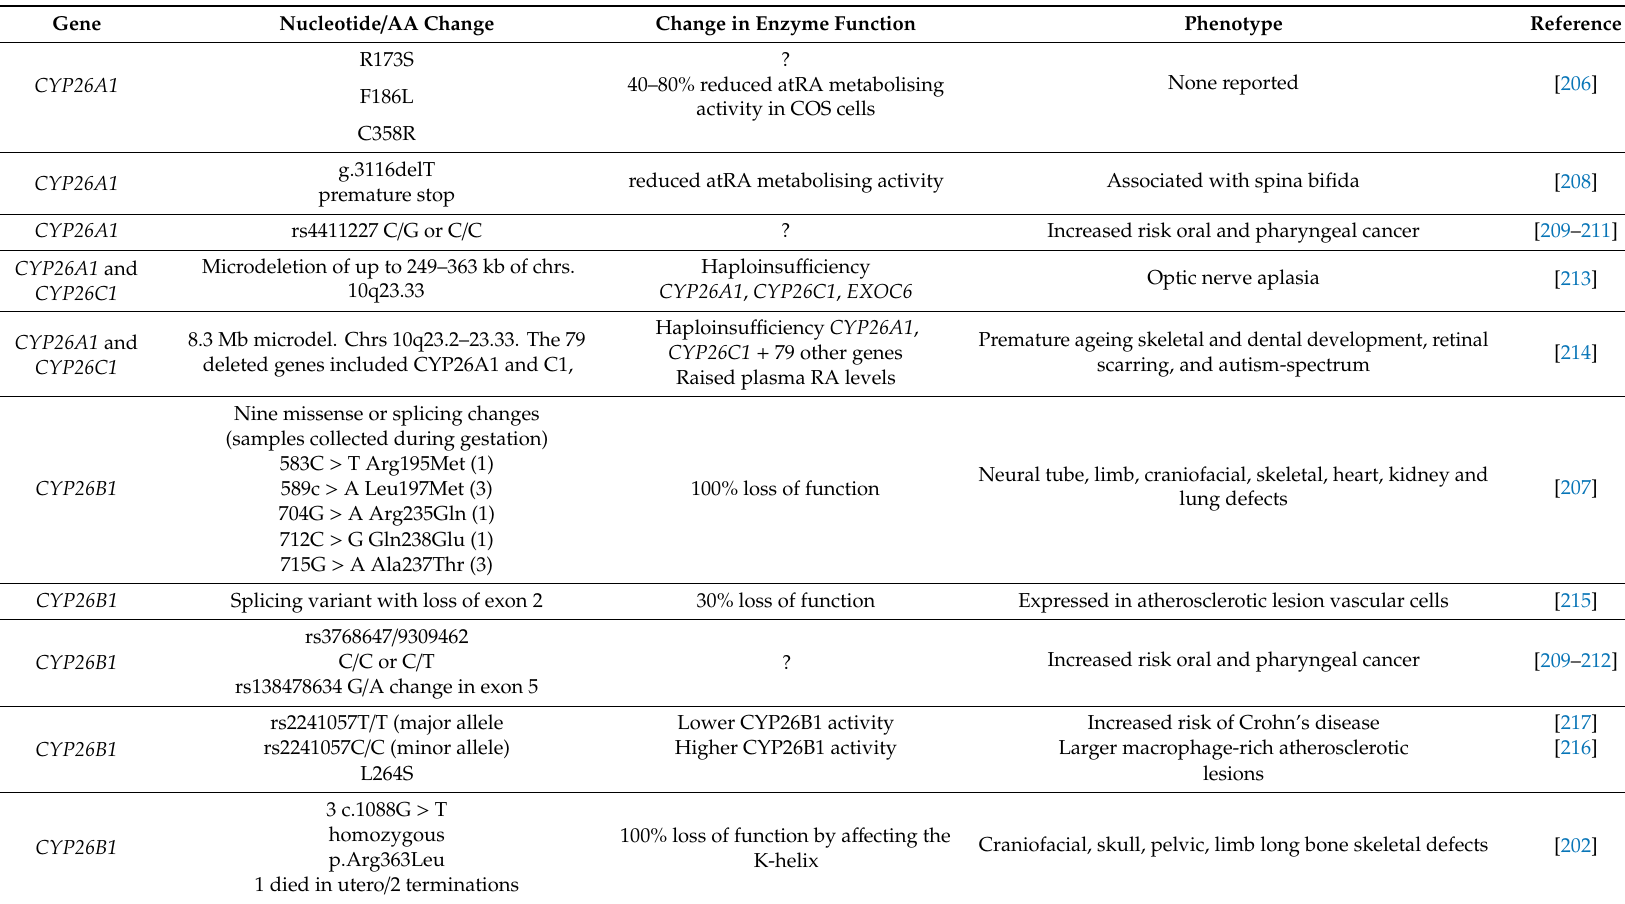
Table 1. Summary of Phenotype Causing Mutations in Human CYP26